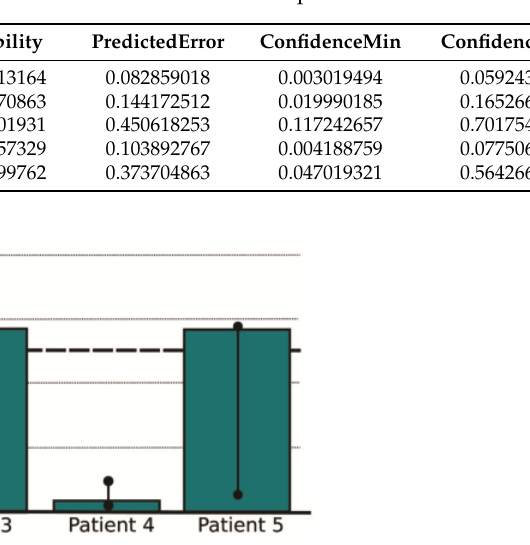
Figure 7. Risk prediction report from the Risk Stratification Tool for the selected five patients.